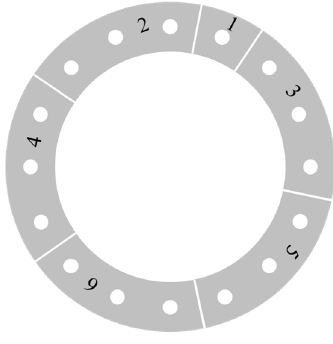
Figure 5. Schematic of a tube ring.